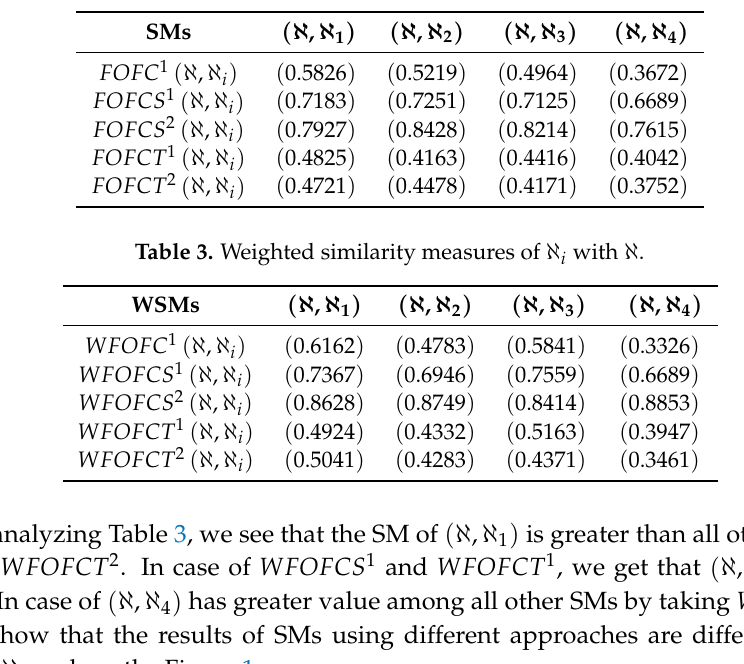
Table 2. Similarity measures of ℵ i with ℵ .